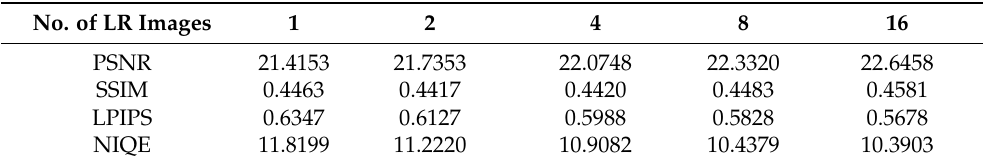
Table 3. Qualitative comparison of the proposed scheme on the aligned dataset depicted in Figure 10. Each evaluation was conducted using the SR result corresponding to the LR image with averaged noise. The top row depicts the number of images used for average